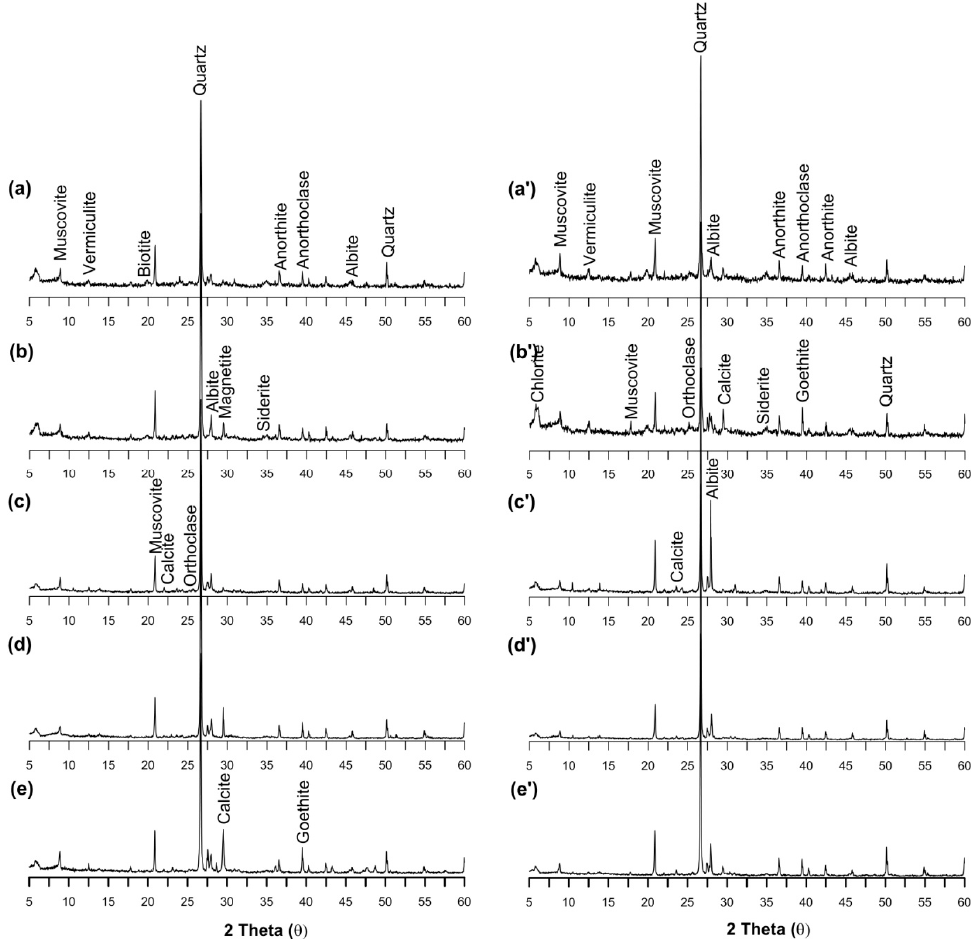
Figure 9. X-ray diffraction spectra for core profile of Rigni Chhapra with a comparision of five depths of ( a ) yellowish silty clay at 0.5 m ( b ) micaceous medium sand (dark grey) with OM at 1.5 m ( c ) yellowish grey fine sand at 6.1 m ( d ) grey to yellowish medium sand with OM at 15.2 m ( e ) grey fine sand with OM at 30.5 m and of core Chaube Chhapra ( a’ ) yellowish silty clay at 1.5 m ( b’ ) micaceous medium sand (dark grey) with OM at 3.0 m ( c’ ) yellowish grey fine sand at 6.1 m ( d’ ) grey to yellowish medium sand with OM at 15.2 m ( e’ ) grey fine sand with OM at 30.5 m.